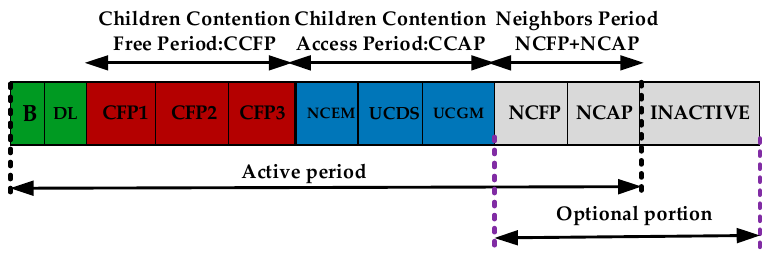
Figure 9. Superframe structure of the Priority-Based Cross Layer Routing Protocol (PCLRP) protocol.